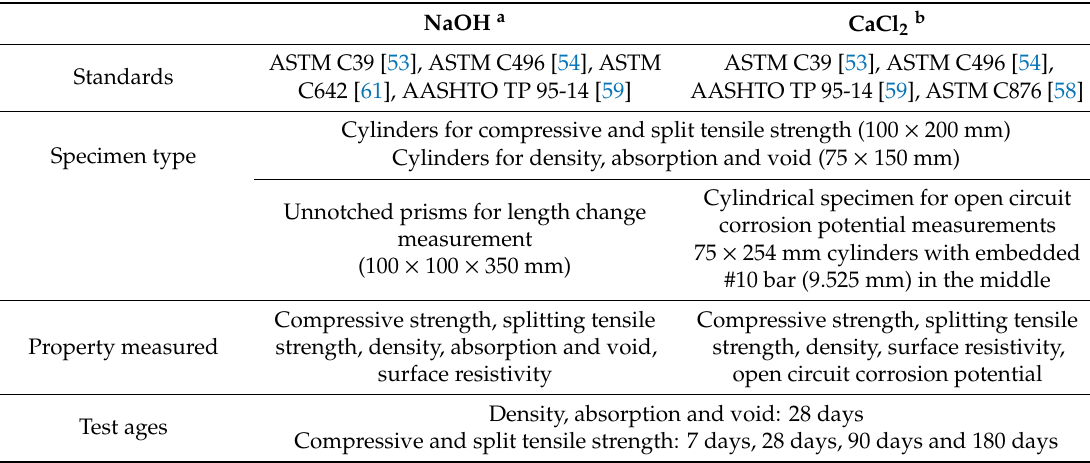
Table 4. Test plan for the series of smaller batches of concrete mixtures with Type I / II cement and Brazos reactive sand containing di ff erent levels of NaOH and CaCl 2 .